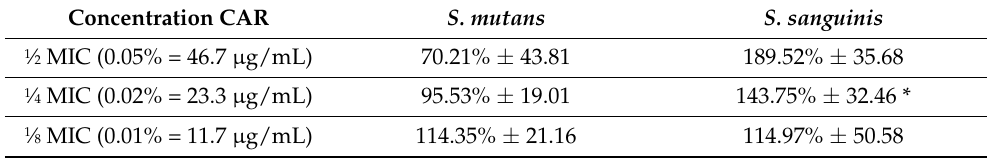
Table 1. Percentaje of Slime Index values for sub-MIC concentrations of CAR.